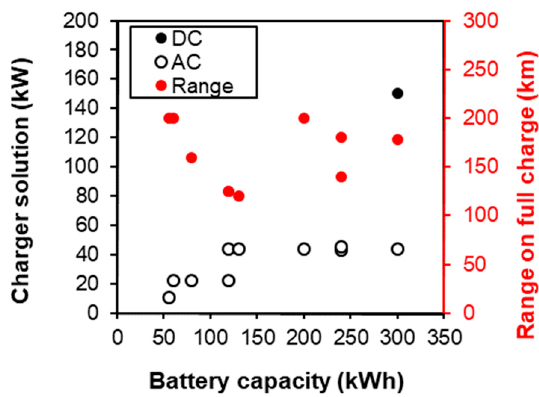
Figure 1. Summary of the battery capacity (kWh) and charging solution (AC or DC, kW) used by the operators. The range on full charge is also shown (in red).